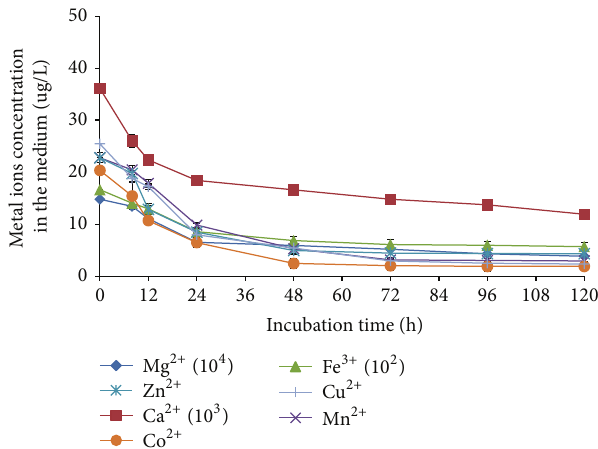
Figure 4: Concentration of metal ions left in culture medium throughout the cultivation of C. bainieri 2A1. The culture was cultivated in 500 mL shake flask containing 200 mL of nitrogen- limited medium at 30 ∘ C, 200 rpm, and starting inoculums of 10% (v/v). The data represent means ± SDs, 𝑛 = 3